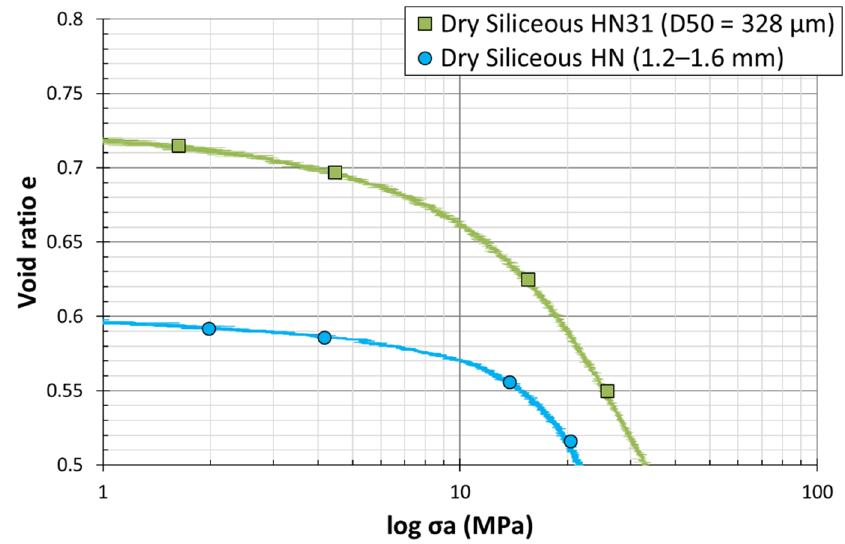
Figure 13. Magnification of the first part of the load–settlement curves from dry odometer tests on siliceous sand grains of two different sizes ( D 50 = 328 µm vs 1.415 mm). The first part represents low stress levels ( σ = 100 MPa) until reaching the yield point.